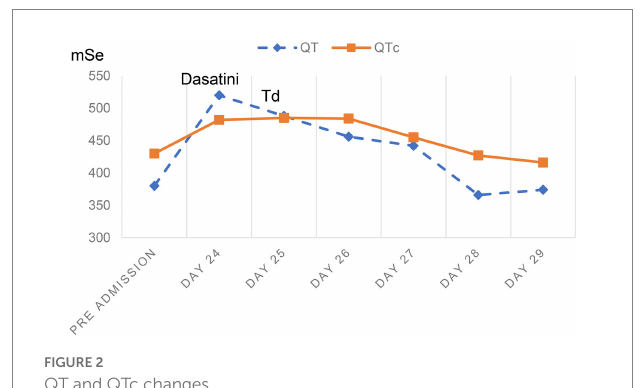
FIGURE 2 QT and QTc